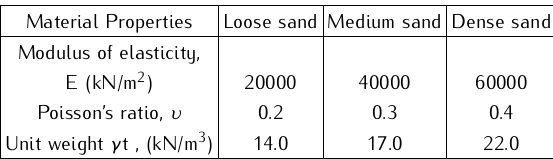
Table 1. Properties of the sandy soil used in the parametric